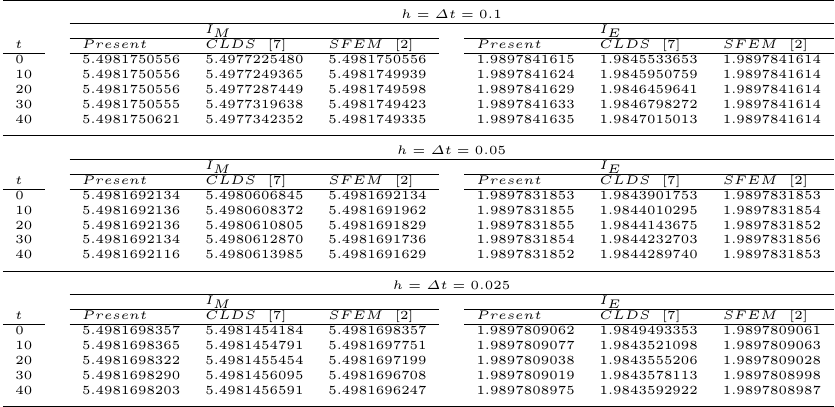
Table 2. Comparison of conserved quantities for single solitary wave with a = b = c = 1, d = 0 . 5, v = 1 . 18 and different values of h and ∆t .